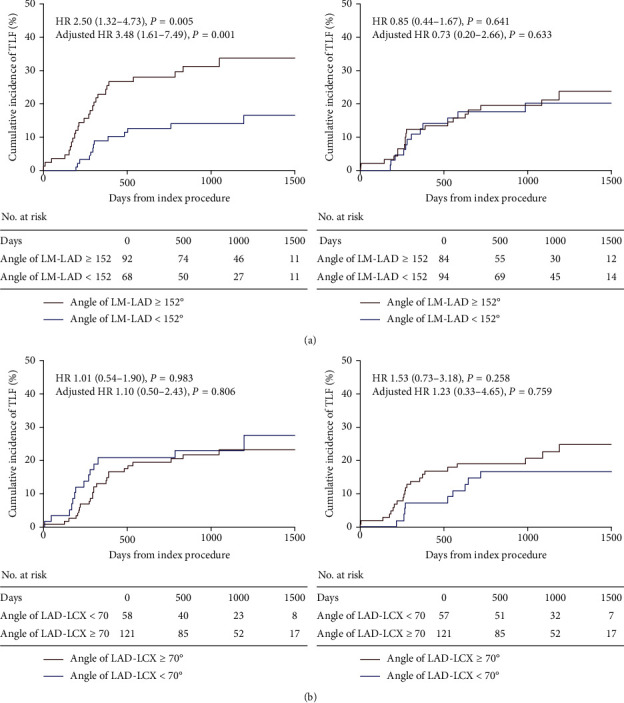
Clinical impact of bifurcation angle after LM PCI using the crush technique versus T-stenting. (a) The clinical impact of LM-LAD angle after left main percutaneous coronary intervention using the crush technique versus T-stenting. (b) The clinical impact of the LAD-LCX angle after left main percutaneous coronary intervention using the crush technique versus T-stenting. HR, hazard ratio; LAD, left anterior descending artery; LCX, left circumflex artery; LM, left main; and PCI, percutaneous coronary intervention. The left column represents the crush strategy, and the right column represents the T-stenting strategy.